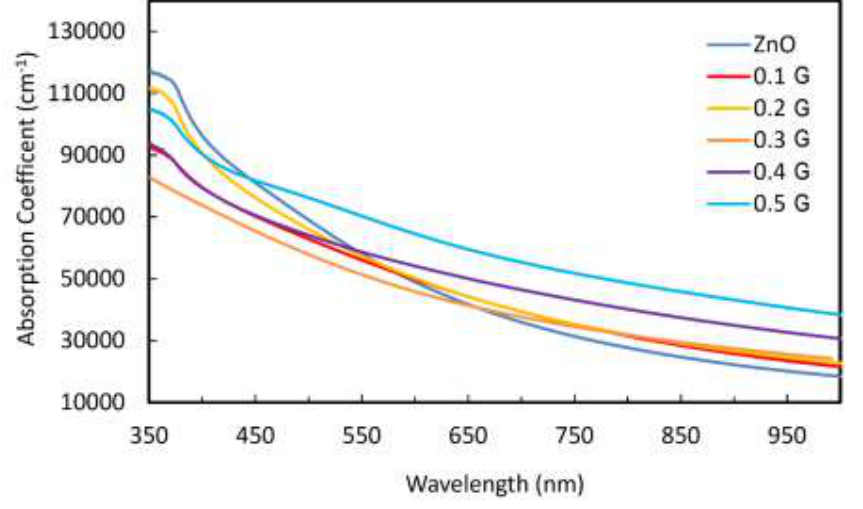
Figure 4: Absorption coefficient spectrum of the nanohybrid graphene-ZnO thin films at different